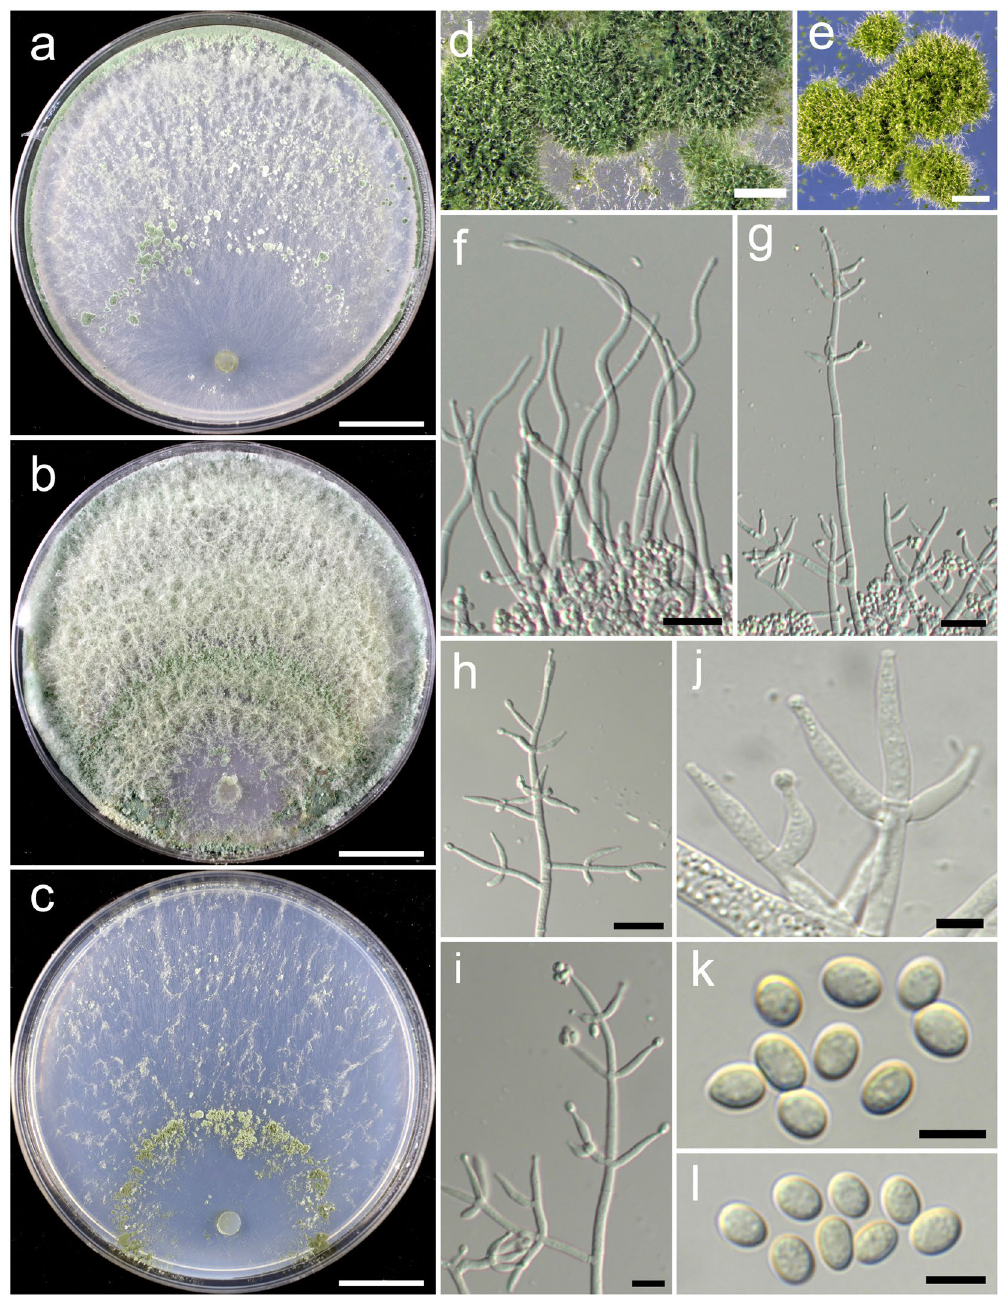
Figure 13. Trichoderma hirsutum (HMAS 248834). ( a–c ) Cultures at 25 °C, 7 d (a. on CMD; b. on PDA; c. on SNA); ( d–e ) Conidial pustules (d. CMD, 7 d; e. SNA, 7 d); ( f–j ) Conidiophores and phialides (PDA, 4 d); (k–l) Conidia (PDA, 4 d). Bars: a–c = 20 mm. d–e = 400 μ m. f–h = 20 μ m. i = 10 μ m. j–l = 5 μ